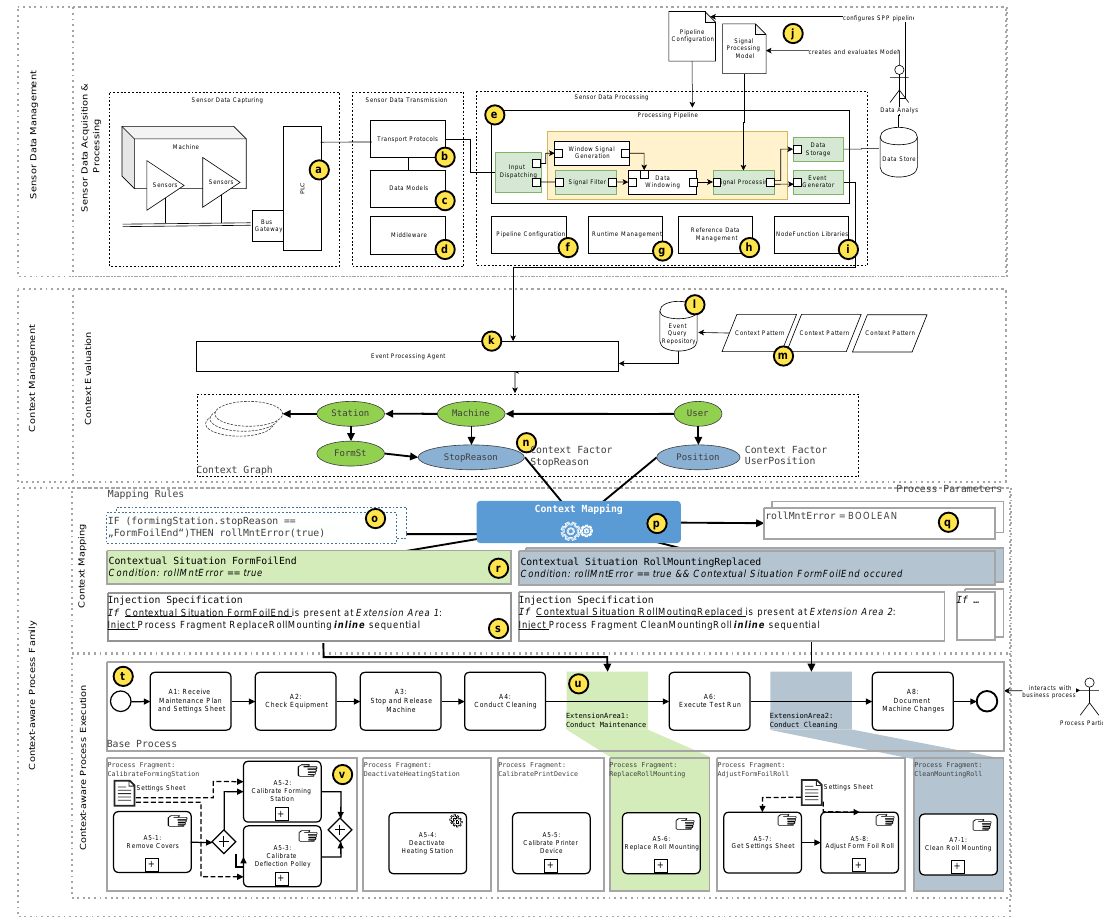
Figure 7. Schematic overview of context-aware process execution